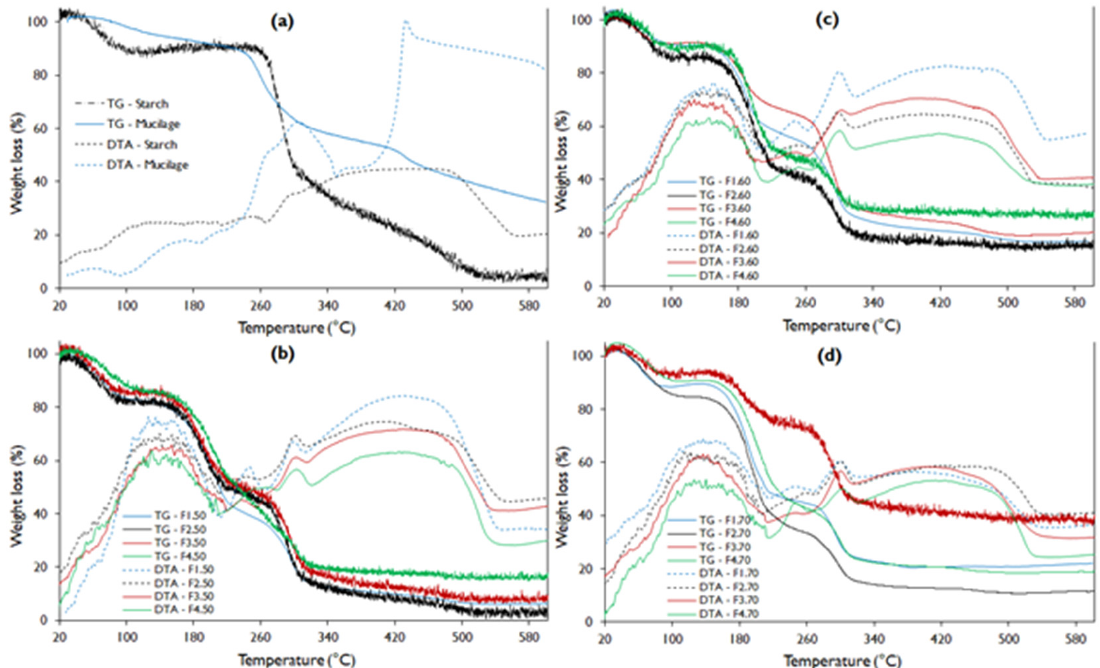
Figure 3. TGA-DTA curve for potato starch, nopal mucilage, and edible film formulations ( a ). Where: TG, thermogravimetric analysis curve; DTA, differential thermal analysis curve ( b – d ). Table 6. Weight loss and decomposition temperature, determined by TGA—DTA.